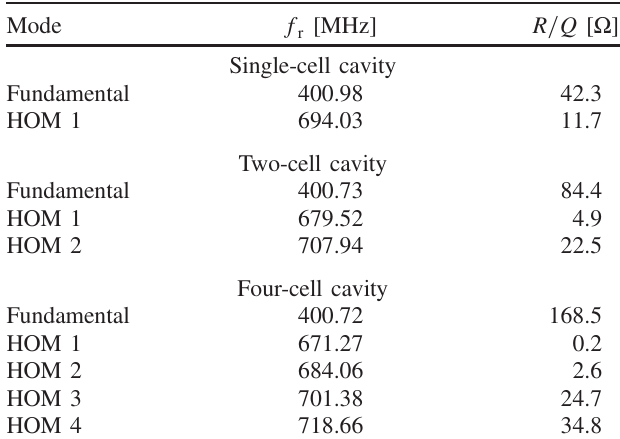
TABLE III. Parameters of the fundamental mode and HOMs with highest R=Q below the cutoff frequency (CST EMS simulation results). The circuit definition is used for R=Q